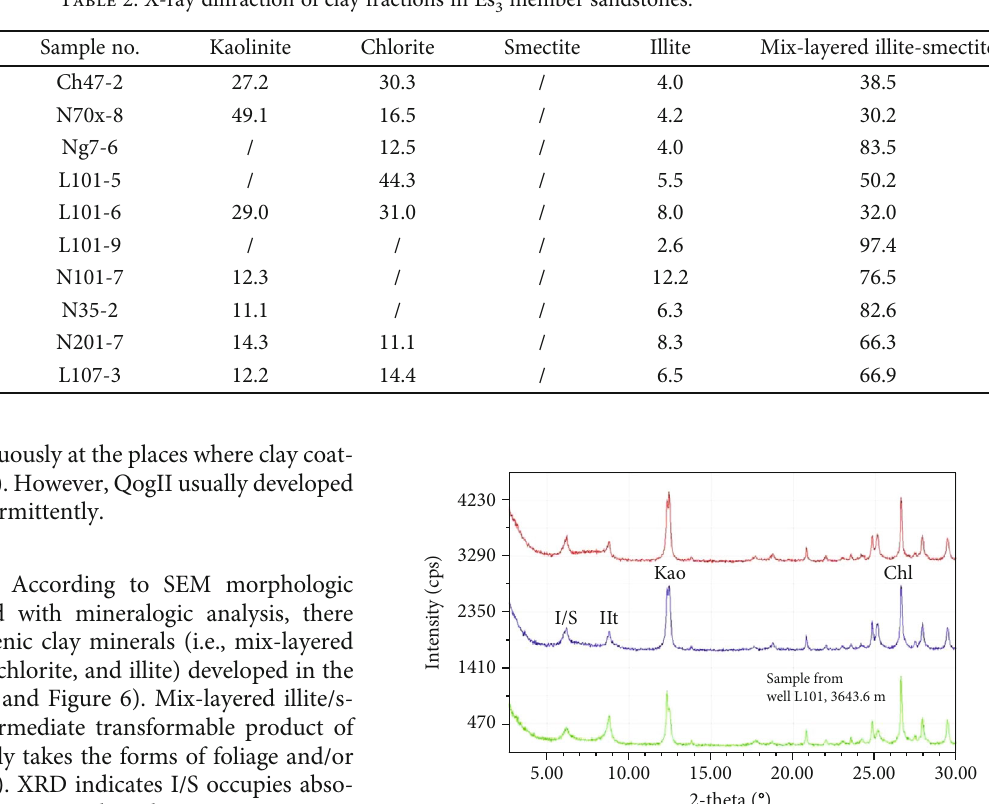
Figure 5: Present (a) and original (b) detrital compositions of the deeply buried Es Table 2: X-ray di ff raction of clay fractions in Es